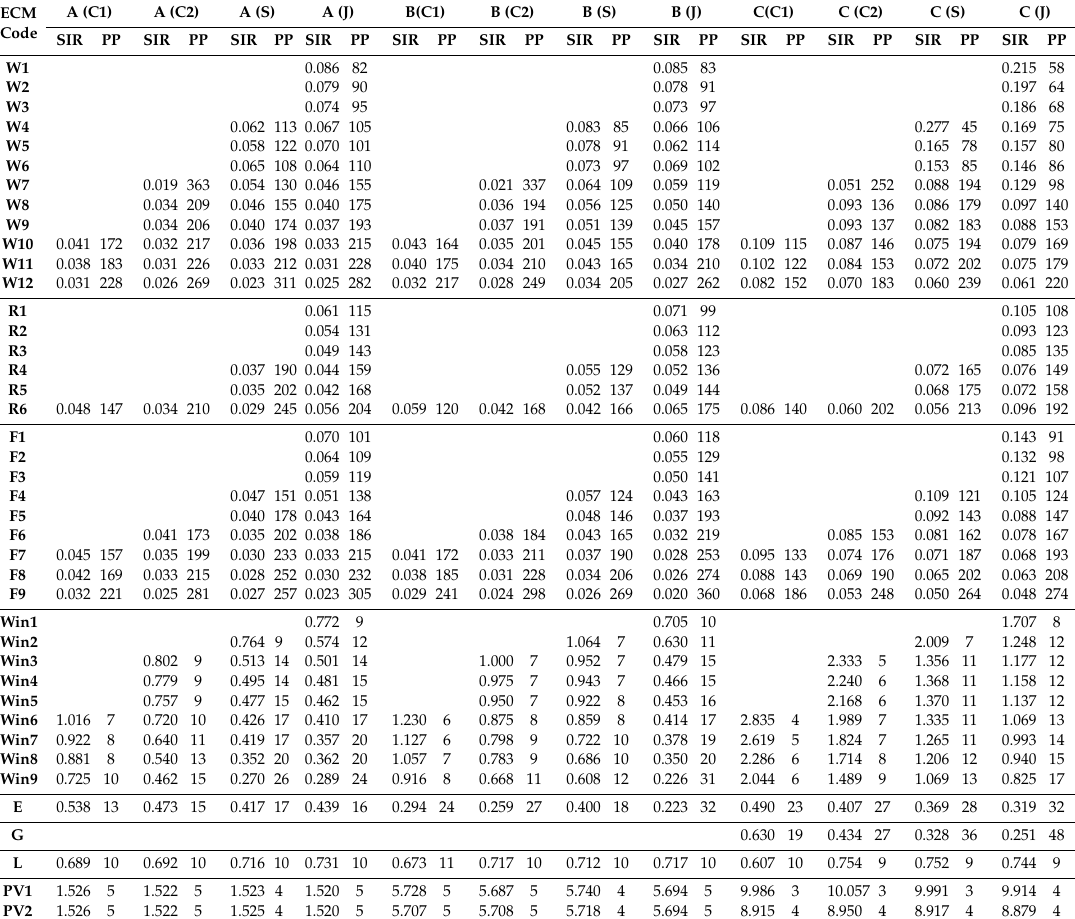
Table 13. SIR (kWh / 1000 KRW) and PP (year) of the single ECM for each reference building in 4 regions. ECM